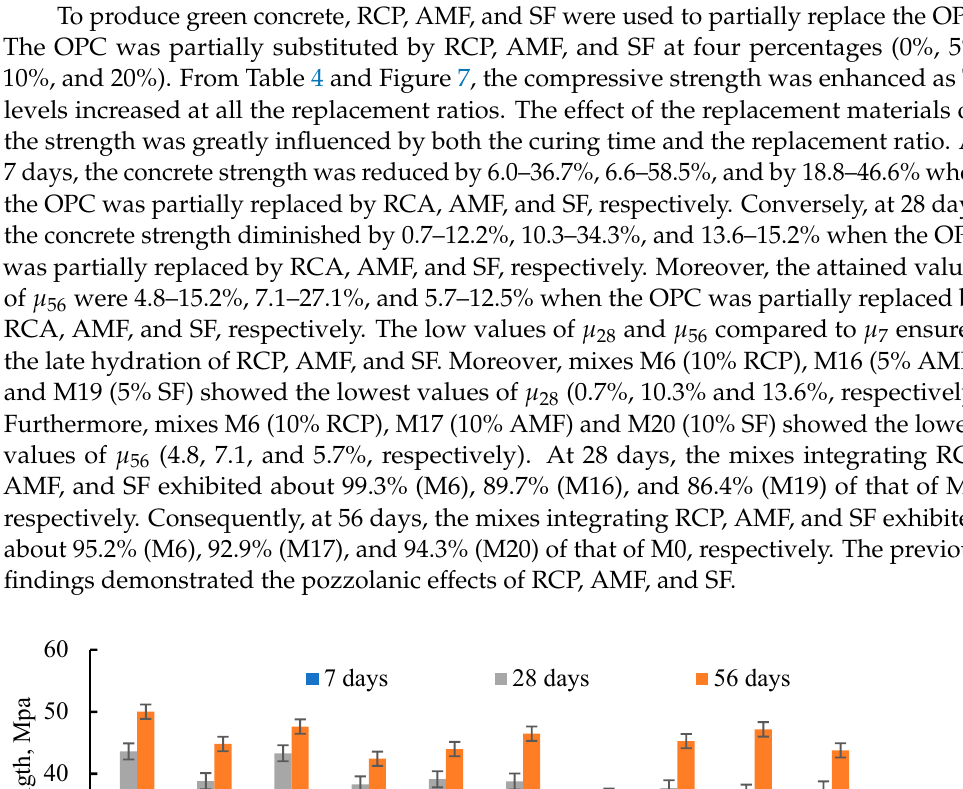
Figure 8. Effects of the RCP, AMF, and SF percentages on Rc7 and Rc56.